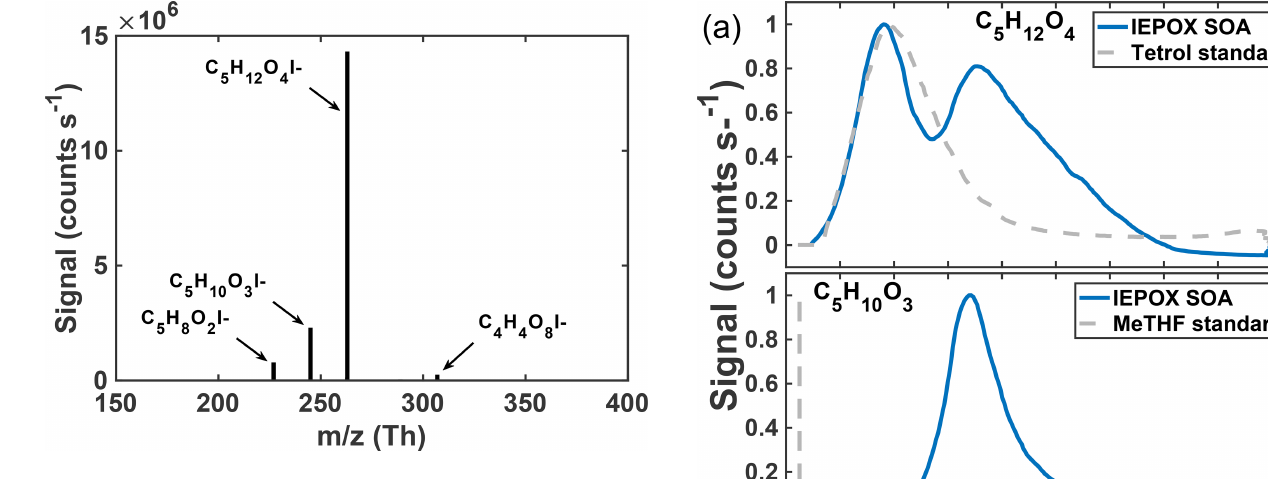
Figure 2. Average mass spectrum of IEPOX-derived SOA at a total OA concentration of 5µgm − 3 .